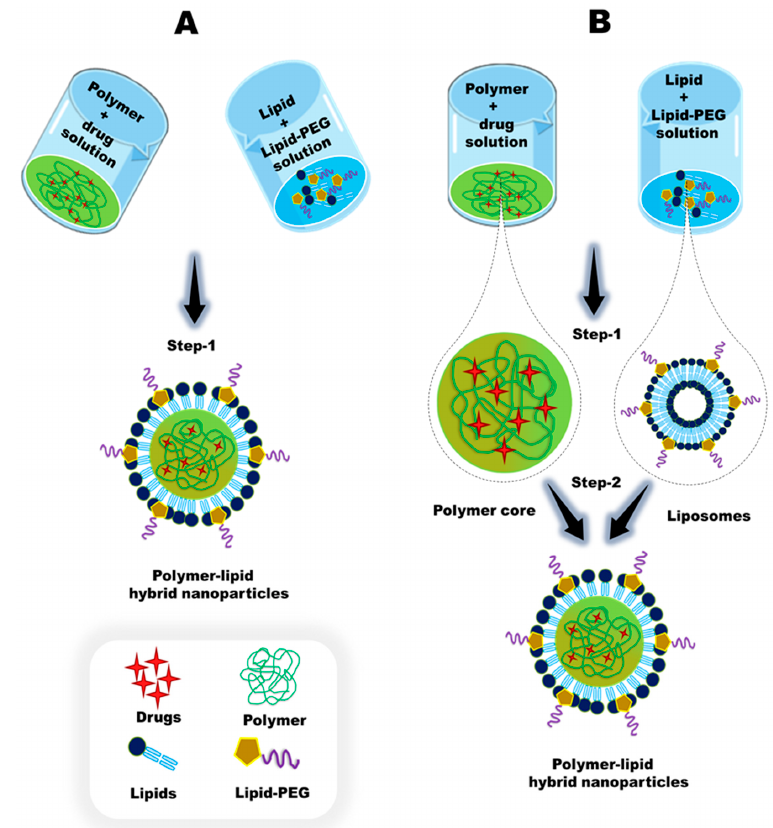
Figure 2. Synthesis of polymer-lipid hybrid nanoparticles. ( A ) One-step synthesis of PLHNPs by mixing drug-containing polymeric solution and aqueous lipid solutions. ( B ) Two-step synthesis of PLHNPs by mixing liposomes with the prepared polymeric drug solutions. Molecules 2020 , 25 , x